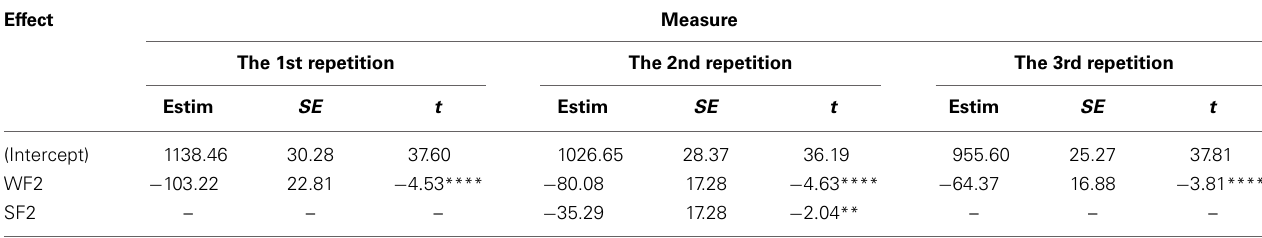
Table 5 | LMM estimates of fixed effects for latencies for each repetition in writing.